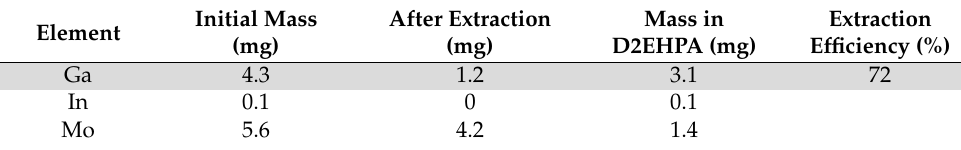
Table 4. Solvent extraction results for